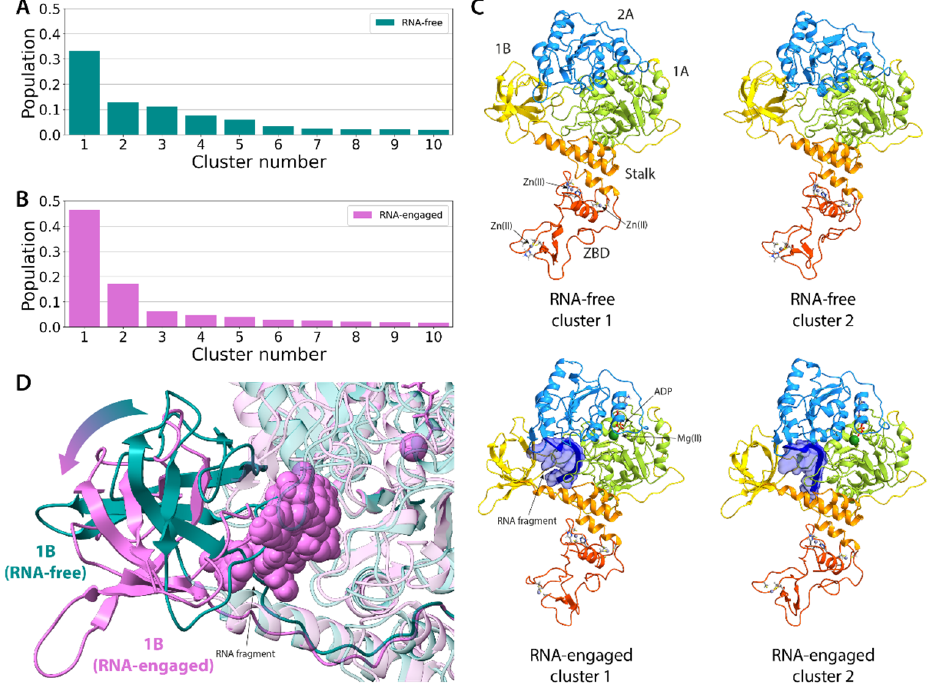
Figure 3. Cluster analysis of the trajectories of NSP13. Panels ( A , B ) show the bar plots of the cluster’s relative population in the RNA-free (dark cyan) and RNA-engaged (orchid) form, respectively. ( C ) Representative structures of the two most populated clusters in each system are shown as ribbons colored as in Figure 1C. The Zn(II) and Mg(II) ions are reported as spheres, while the Zn(II) coordinating residues are shown as sticks. All the atoms are colored according to the atom type. The RNA fragment is displayed as blue ribbons and the molecular surface is shown in light blue. ( D ) Details of the displacement of the 1B domain passing from the RNA-free (dark cyan ribbons) to the RNA-engaged (orchid) form. The arrow indicates the direction of the conformational rearrangement. The RNA atoms are shown as orchid-colored